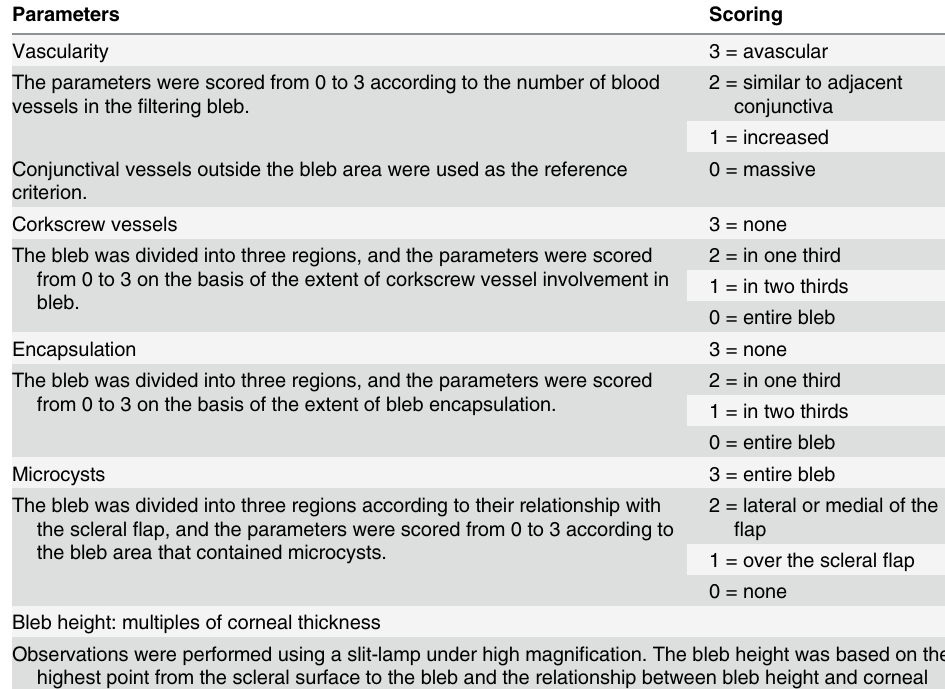
* Table from: Klink T, Schrey S, Elsesser U, Klink J, Schlunck G, Grehn F. [31] Interobserver variability of the Wurzburg bleb classi fi cation score. Ophthalmologica. 2008; 222: 408 –